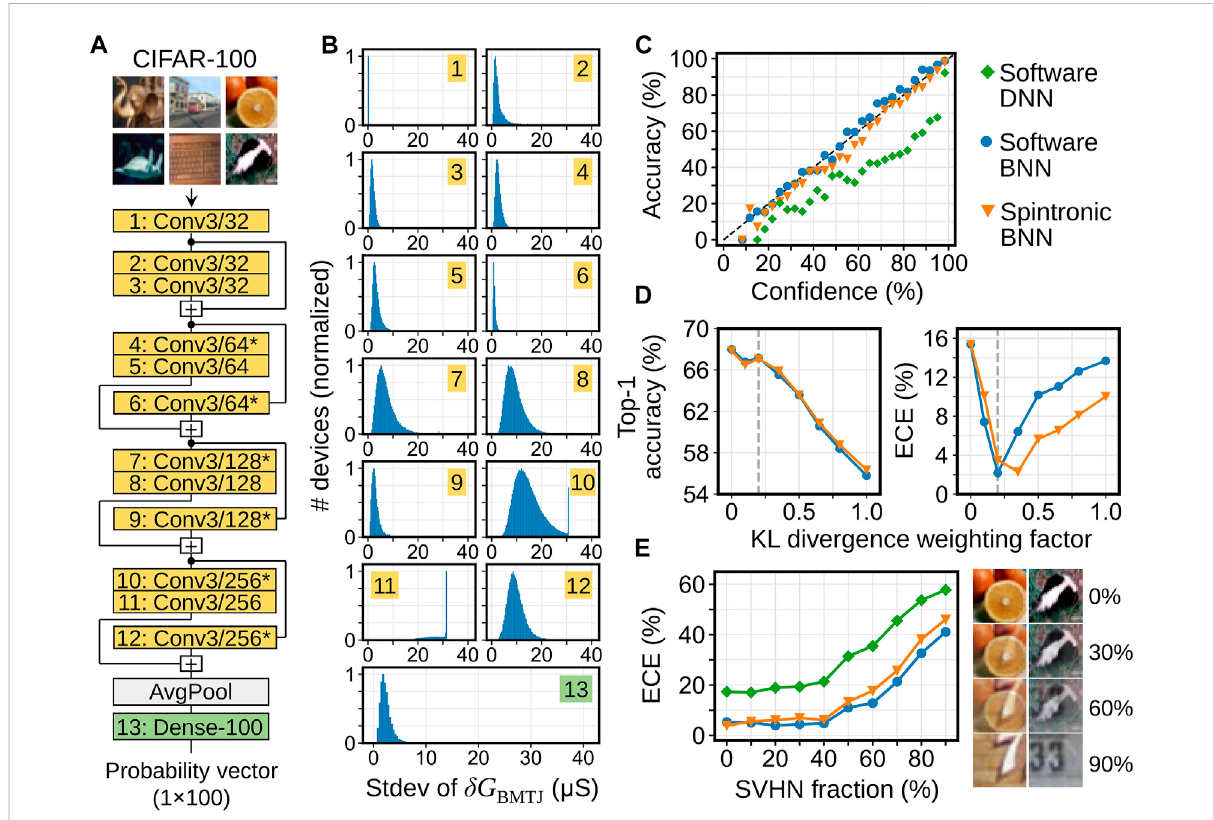
FIGURE 6 (A) ResNet topology for CIFAR-100 image classi fi cation, used for both the DNN and BNN. An asterisk denotes a stride of two. Convolutions other than layers6, 9, and 12 are followed by batch normalization. (B) Distribution of trained σ values for each layer of the ResNet, mappedto Bayes- MTJconductancenoise. (C) ComparisonofuncertaintycalibrationcurvesfortheResNetDNN,BNN,andBNNsimulatedonspintronichardware,for the CIFAR-100 test set. (D) Accuracy and ECE on the CIFAR-100 test set for various BNNs trained with different weighting factors on the KL divergence term of the loss function. Each network is evaluated both in software and simulated on the spintronic accelerator. (E) ECE vs SVHN fraction for CIFAR-100 images continuously mixed with SVHN images. Results in (C,E) used a BNN with a KL divergence weighting factor of 0.2 and 100 samples per prediction. Results in (D) are based on 25 samples per